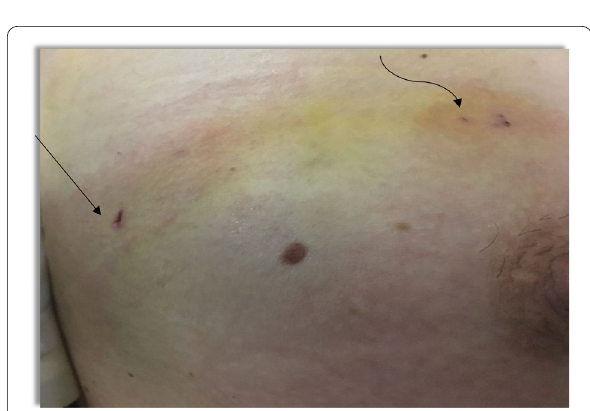
Fig. 4 Shows straight line showing site of entrance of needle and curved connector showing ecchymosis